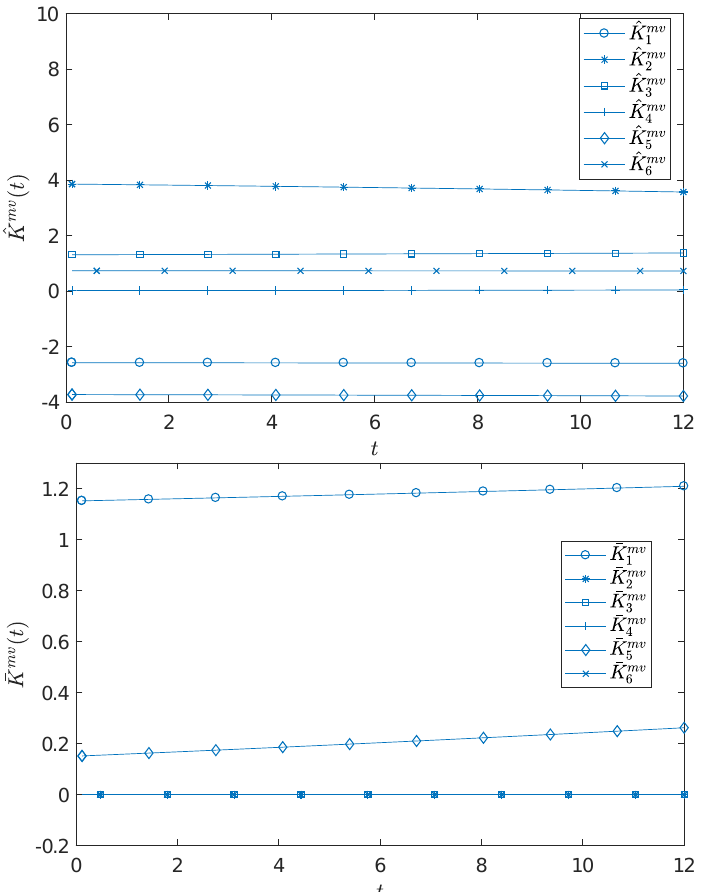
Figure 1. The outputs of ˆ K mv ( t ) and ¯ K mv ( t )